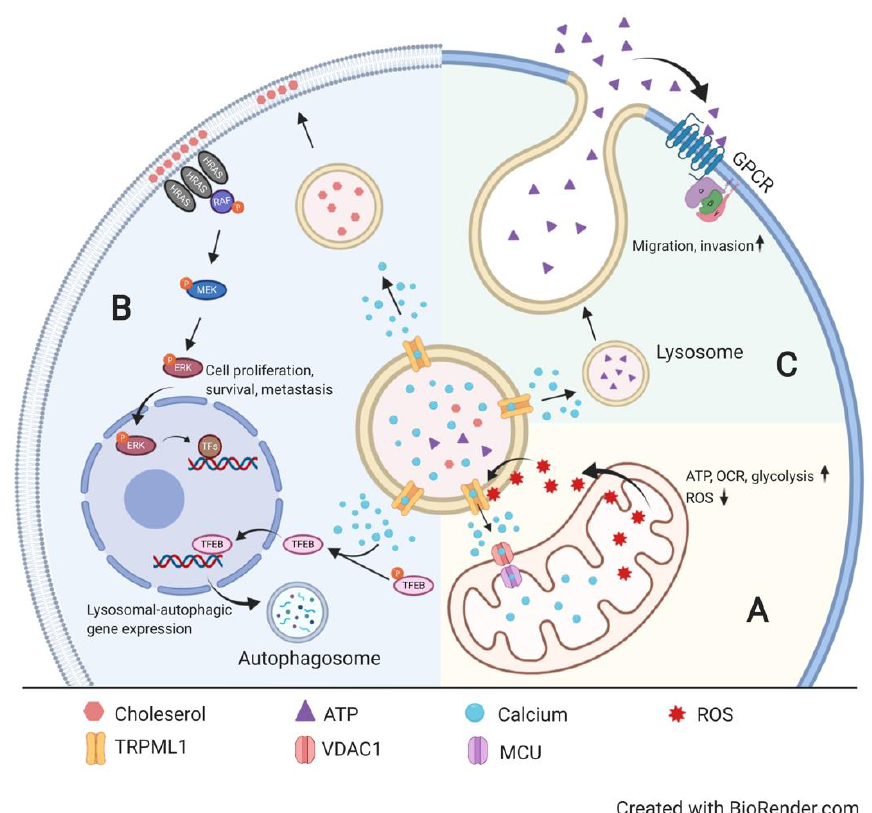
Figure 1. Mucolipin-1 (TRPML1) signaling in physiology and oncogenesis. ( A ) Mitochondrial reactive oxygen species (ROS) trigger TRPML1-mediated lysosomal Ca 2+ release [9] , which, in turn, facilitates mitochondrial Ca 2+ uptake through voltage-dependent anion channel 1 (VDAC1) and mitochondrial calcium uniporter (MCU) on the outer and inner mitochondrial membrane, respectively [10] . This influx of lysosomal Ca 2+ into the mitochondria increases mitochondrial oxygen consumption rate (OCR) and overall cellular bioenergetic output while keeping ROS production in check [11] . ( B ) TRPML1-mediated lysosomal Ca 2+ release facilitates nuclear translocation of transcription factor EB (TFEB), stimulating transcriptional machineries of lysosomal biogenesis and autophagic flux in normal cells [9] . On the other hand, in HRAS -driven cancers, oncogenic TRPML1 enhances vesicular trafficking of cholesterol to the plasma membrane, enriching membrane-based proliferative signaling pathways [12] . ( C ) TRPML1 mediates extracellular release of lysosomal ATP in cancerous cells, driving tumor migration and invasion [13] . Created with BioRender.com.